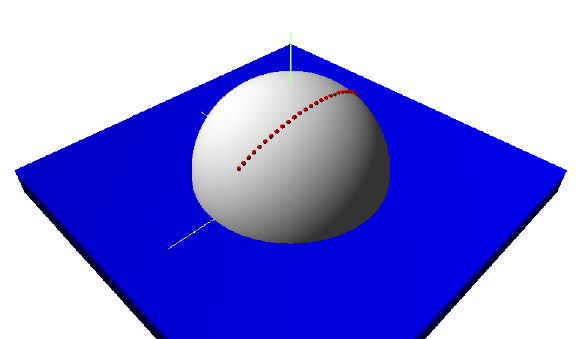
Figure 10. Solar position calculation made by Pysolar.